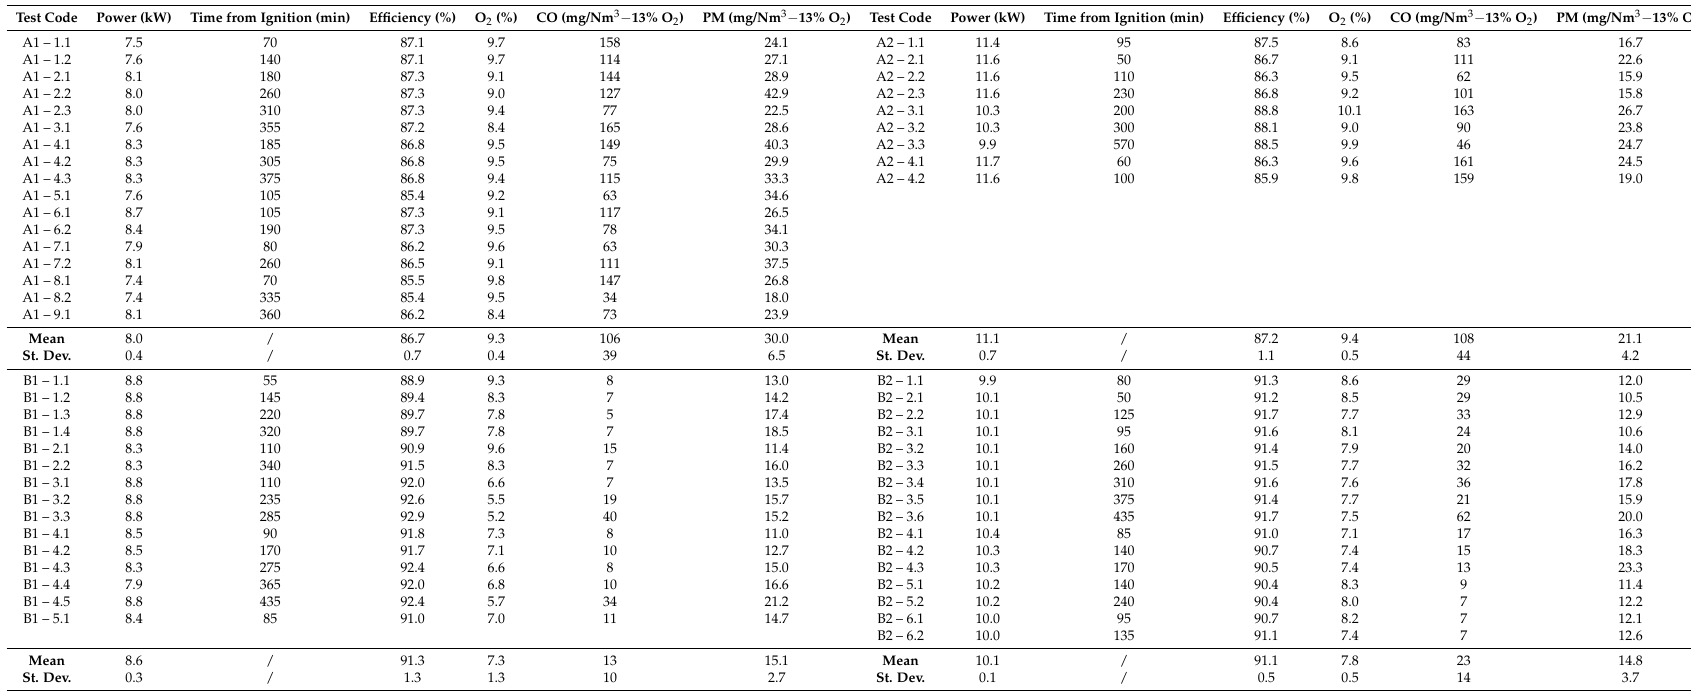
Table 2. Average CO–PM–O 2 values for each test performed with stoves A1, A2, B1, and